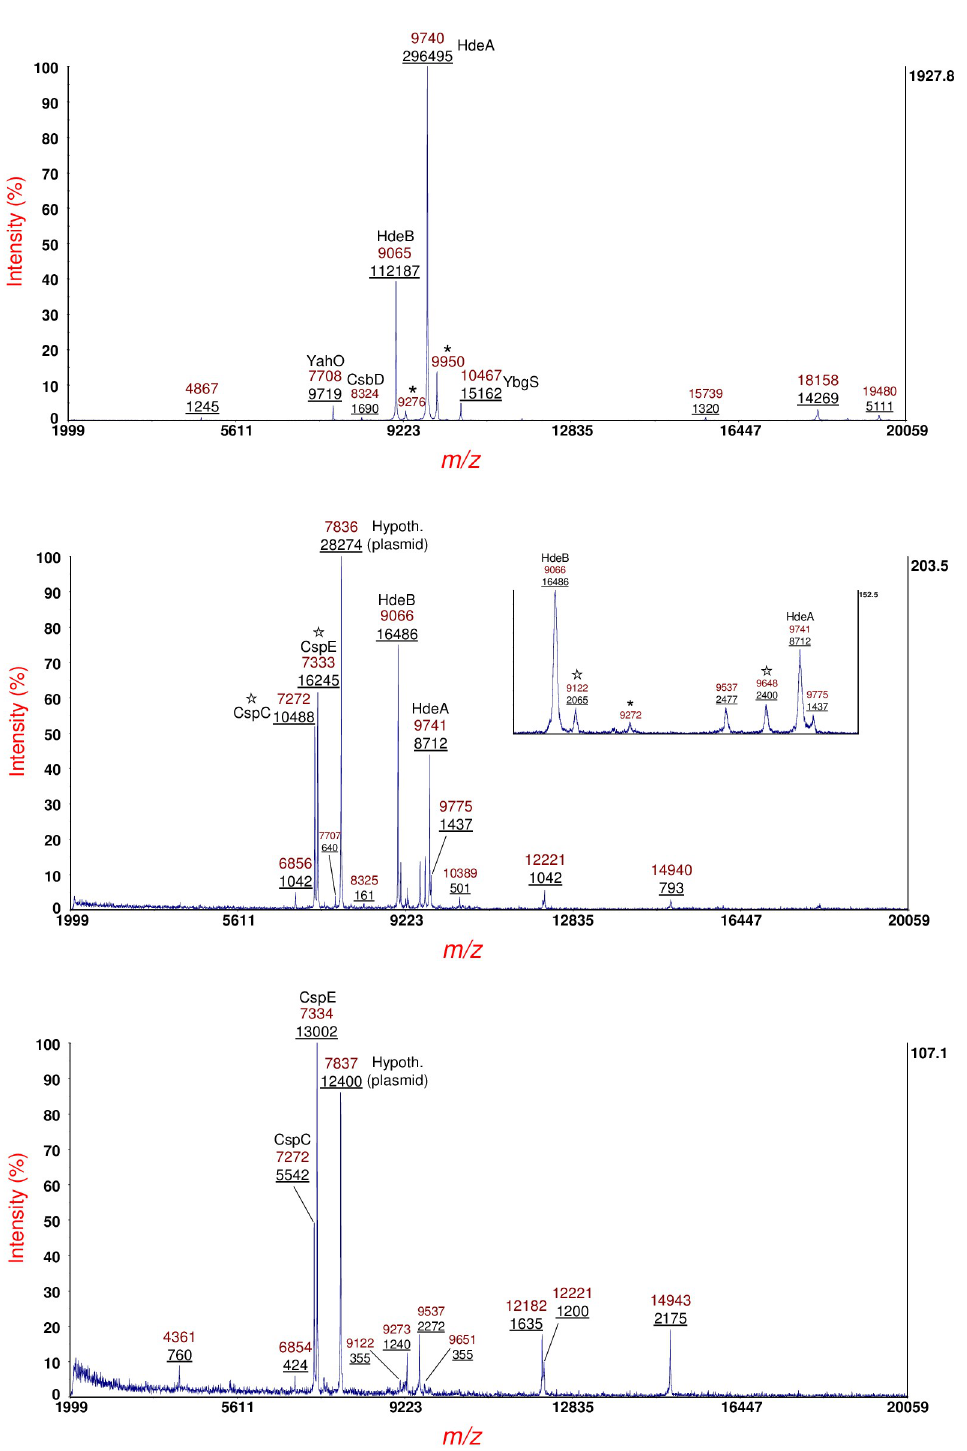
Fig 5. Top panel: MS of sample supernatant of E . coli O113:H21 strain RM7807 cultured overnight on LBA. Middle panel: MS of sample supernatant of strain cultured overnight on LBA supplemented with 400 ng/mL of MMC. An expanded m/z insert is shown. Bottom panel: MS of sample supernatant of strain cultured overnight on LBA supplemented 600 ng/mL of MMC. Prominent protein ions are identified by their m/z . Integrated peak areas (underlined) are provided below the m/z . Protein ions marked with an asterisk are matrix adducts. Protein ions marked with a star were analyzed by MS/MS. Conserved E . coli host proteins, e.g. acid stress proteins HdeA and HdeB, as well as YahO and YbgS, are labeled based on previous